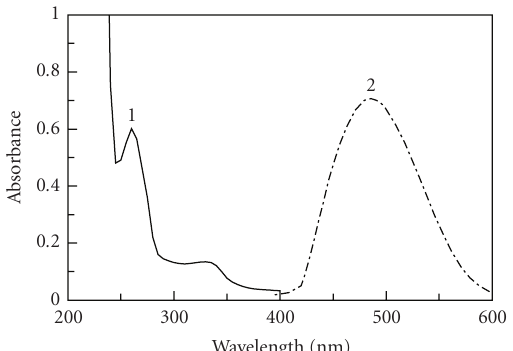
Figure 1: Absorption spectra of FLX (100 μ gmL − 1 ) against water (1) and its reaction product with NQS (0.5%, w/v) against reagent blank (2).